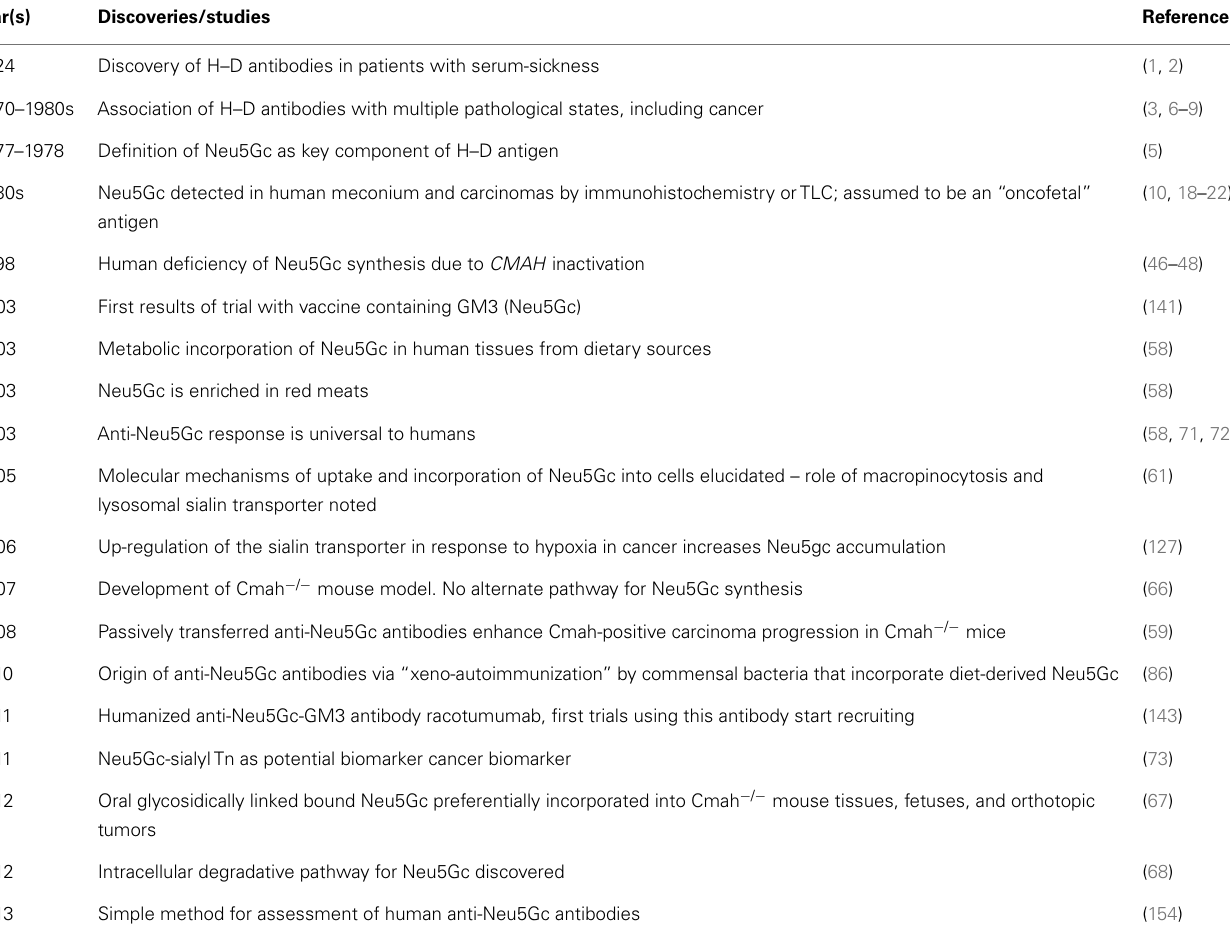
Table 2 |Timeline of discoveries/studies concerning Neu5Gc and anti-Neu5Gc antibodies